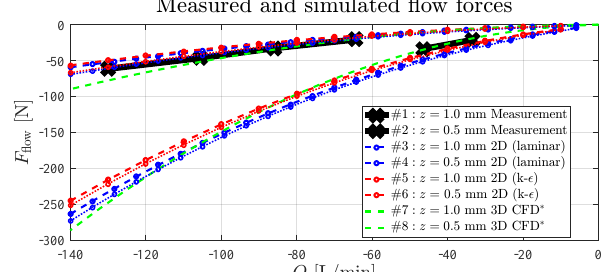
Figure 13: Estimated and simulated steady-state ax- ial flow induced forces (sign convention in Fig. 3). Further information on the 3D CFD* simulation in Roemer et al. (2015). The dotted blue and red line represent the approximation based on the pressure differ- ence i.e. ∆ p valve A shadow using the Laminar and k- (cid:15) results